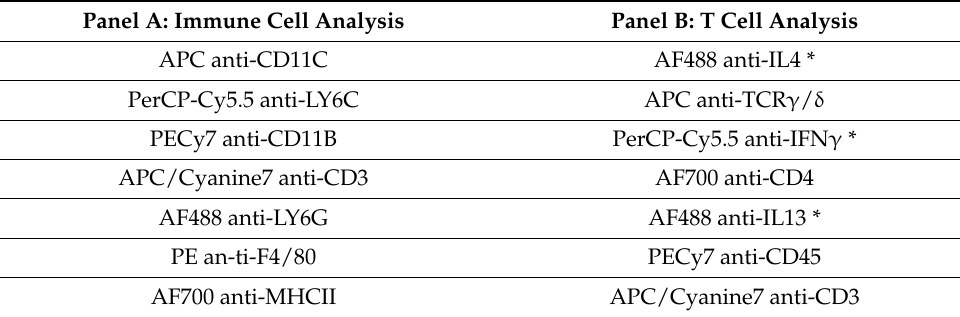
Table 1. Antibodies used for flow cytometry and